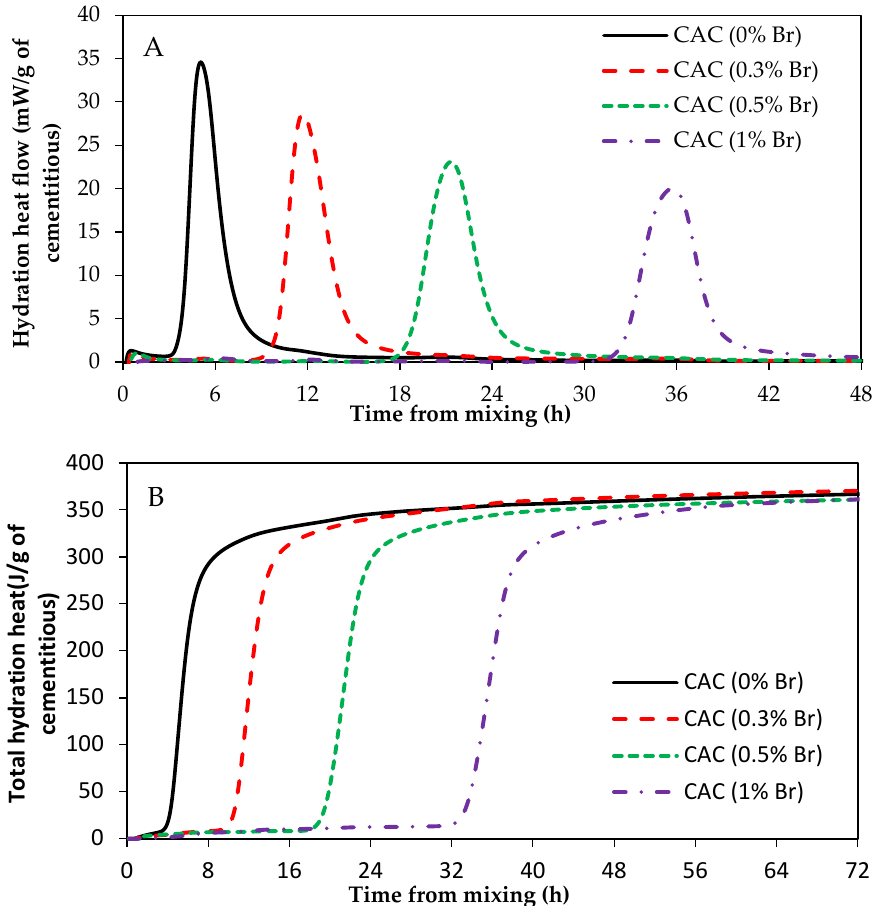
Figure 8. Heat of hydration of CAC with and without borax. ( A ) heat flow; ( B ) total heat.